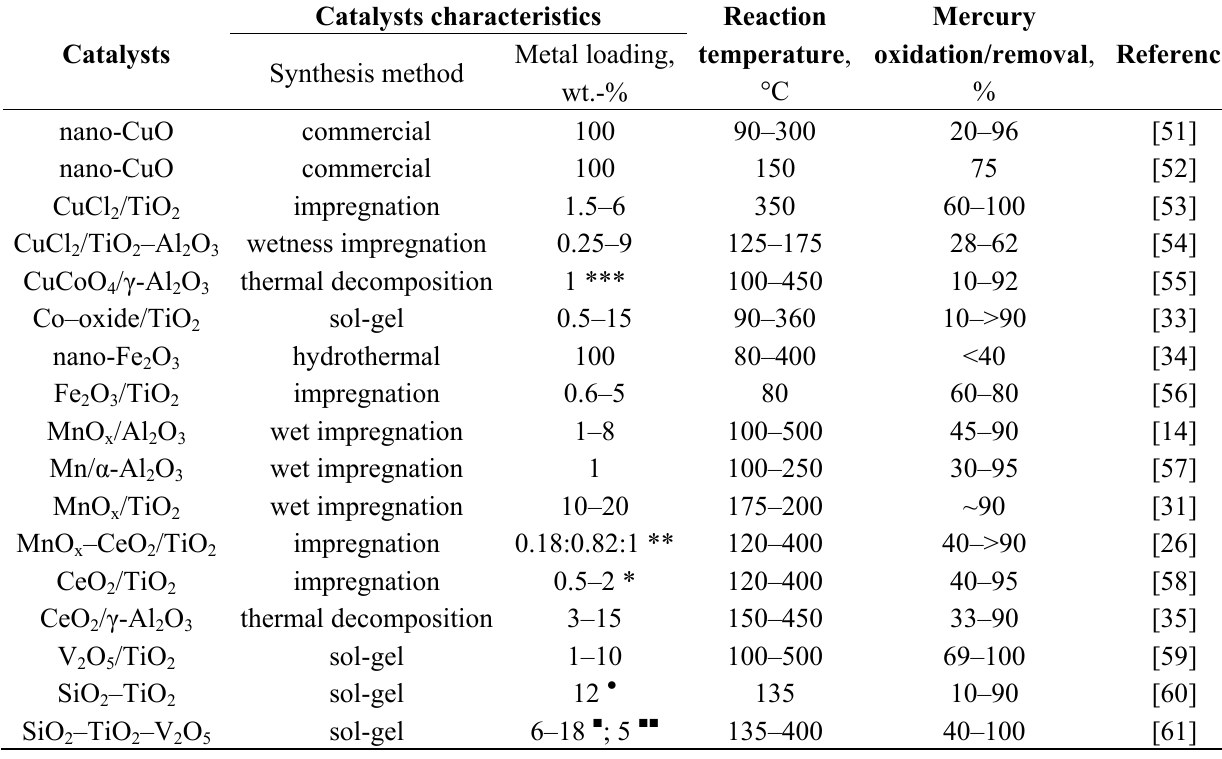
Table 2. Mercury oxidation activity of different supported metals and metal